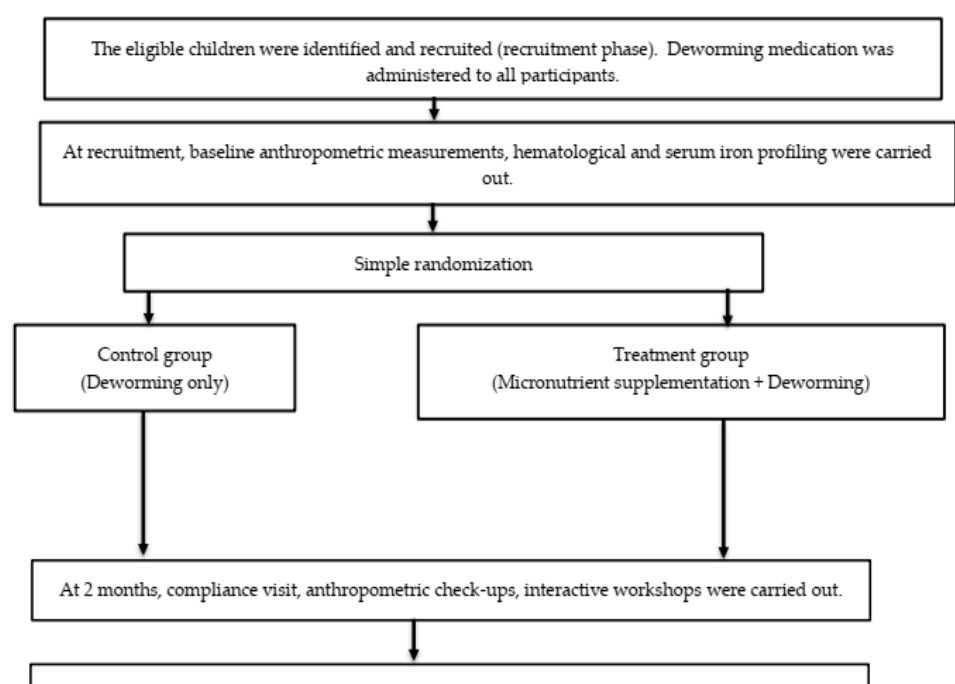
Figure 2. The flow of the study from recruitment until the completion of all follow-up visits.